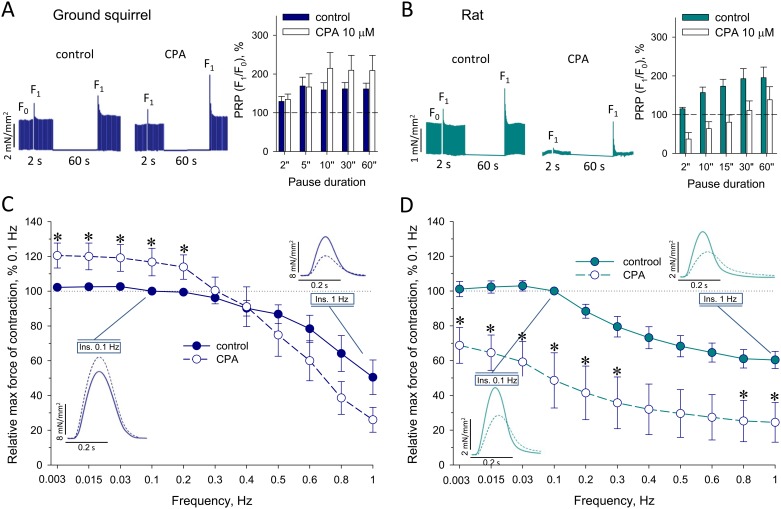
CPA-induced changes in PRP and FFR of PM contractile function.(A and B) Representative recordings of ground squirrel and rat PM contractility implementing 2 s- and 60 s-long pauses along with corresponding PRP, calculated as a percentile ratio of the first post-rest contraction force F1 to the basal rhythmic contraction force F0 (at 1 Hz), plotted as a function of pause durations in the absence and presence of CPA. (C) and (D) Ground squirrels and rat FFR in the absence and presence of 10 μM CPA were constructed as described in Fig 1C and 1D. Insets at 0.1 and 1 Hz represent typical changes in PM contractility induced by CPA (dotted lines); *, denotes statistically significant CPA-induced changes in relative force contraction values (P<0.05; n = 9 in ground squirrels, and n = 3 in rats).